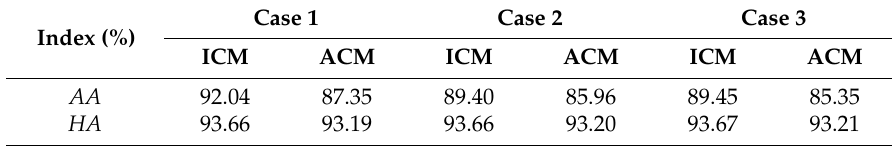
Table 7. Estimation accuracy indices for unbalance contribution